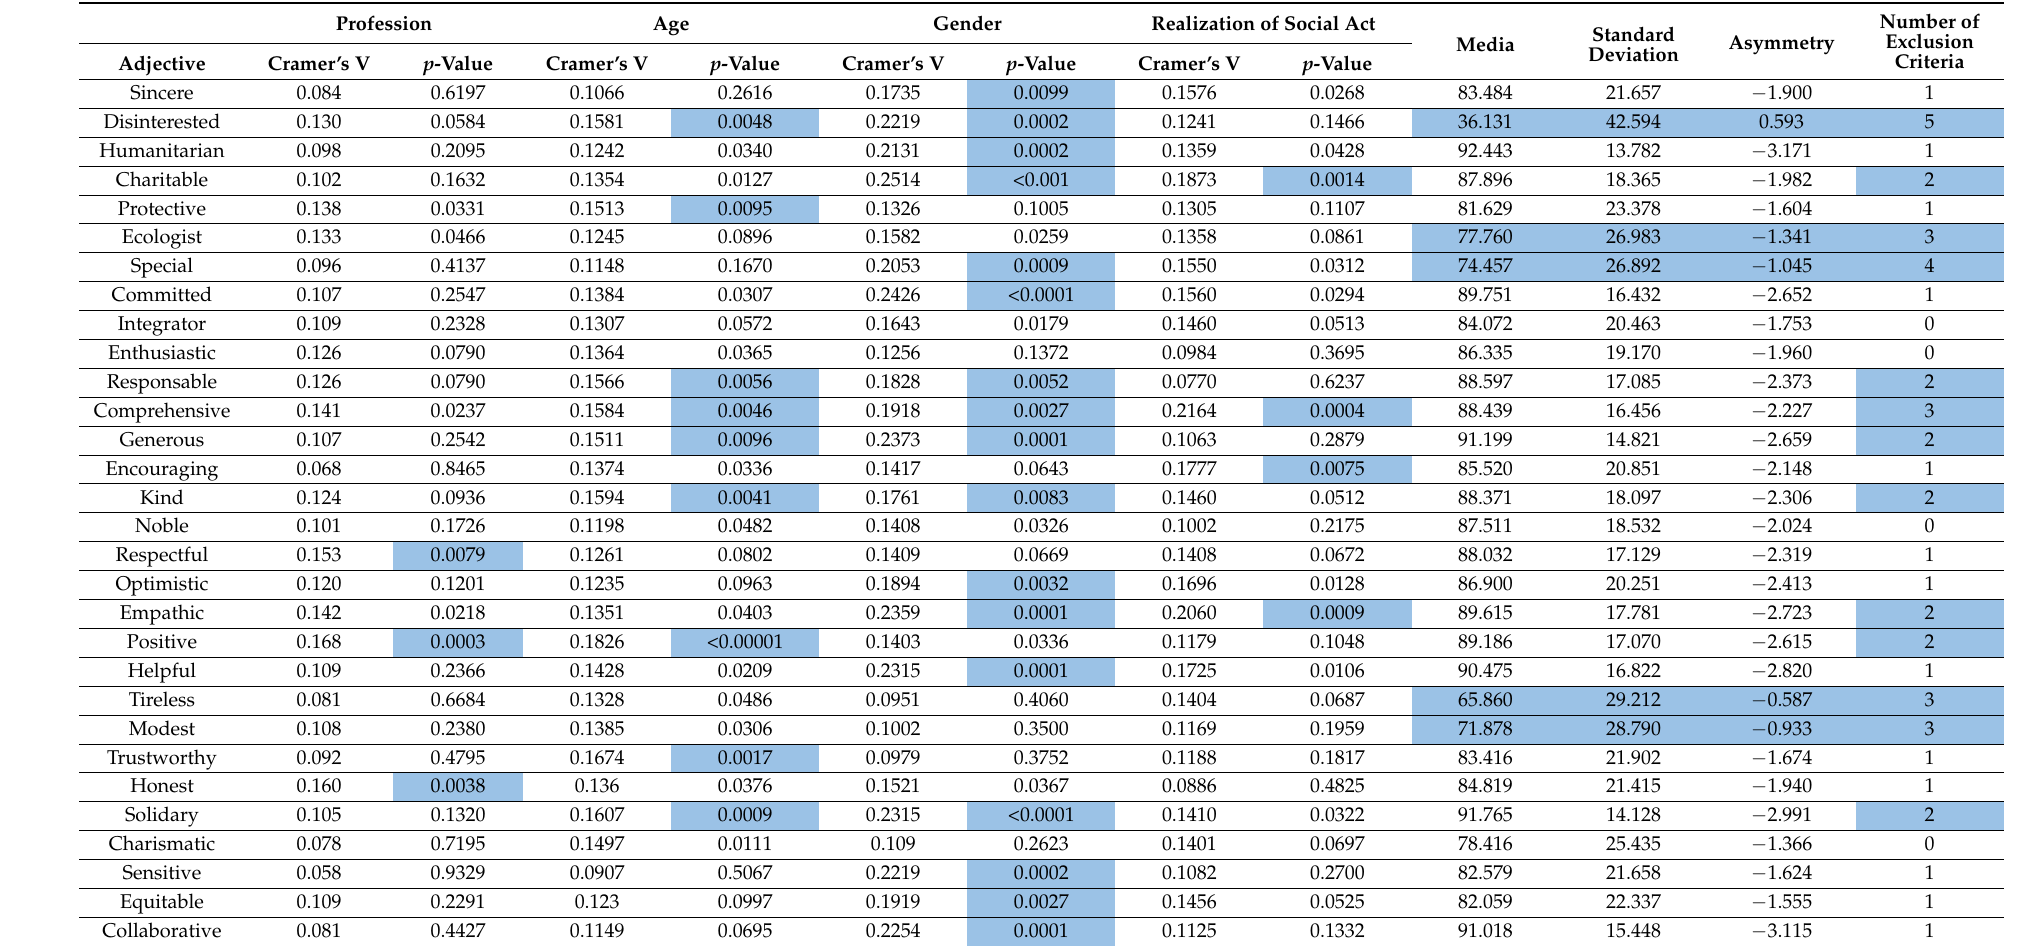
Table 3. Summary of the result of the adjective exclusion